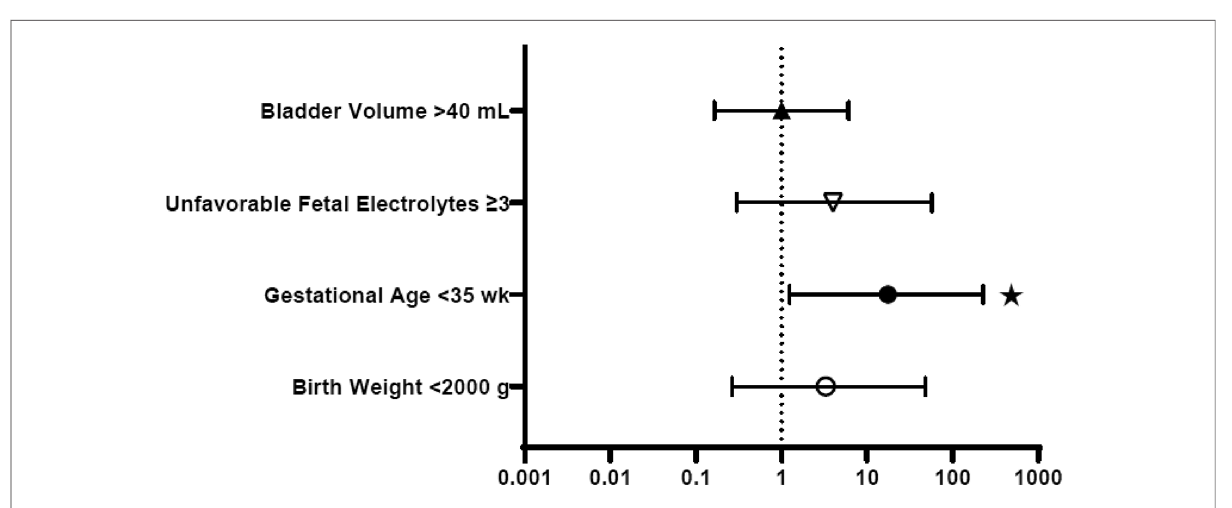
FIGURE 2 Perinatal characteristics: odds ratios for prediction of CKD stage 4 – 5 in the fi rst year of life. * p <0.05.